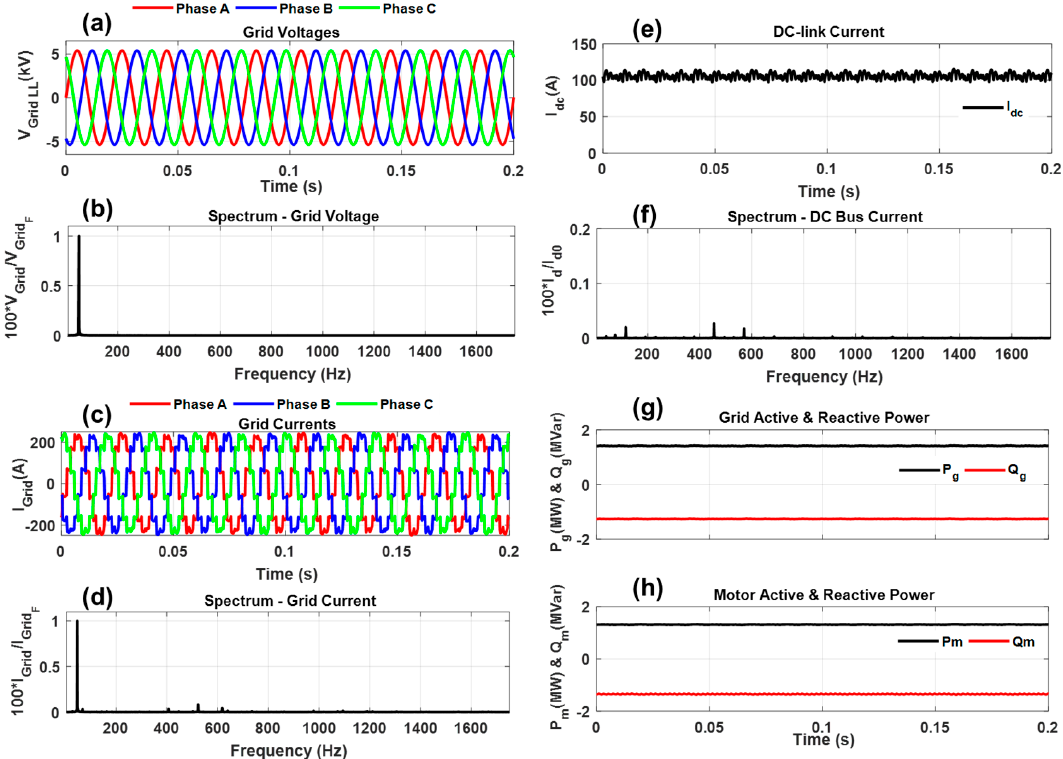
Figure 20. Sample simulation results of a 12/12-pulse LCI system at 40 Hz: ( a ) grid voltages, ( b ) spectrum of grid voltage, ( c ) grid currents, ( d ) spectrum of grid current, ( e ) DC-link current, ( f ) spectrum of DC-link current, ( g ) grid active power and reactive power and ( h ) motor active power and reactive power.